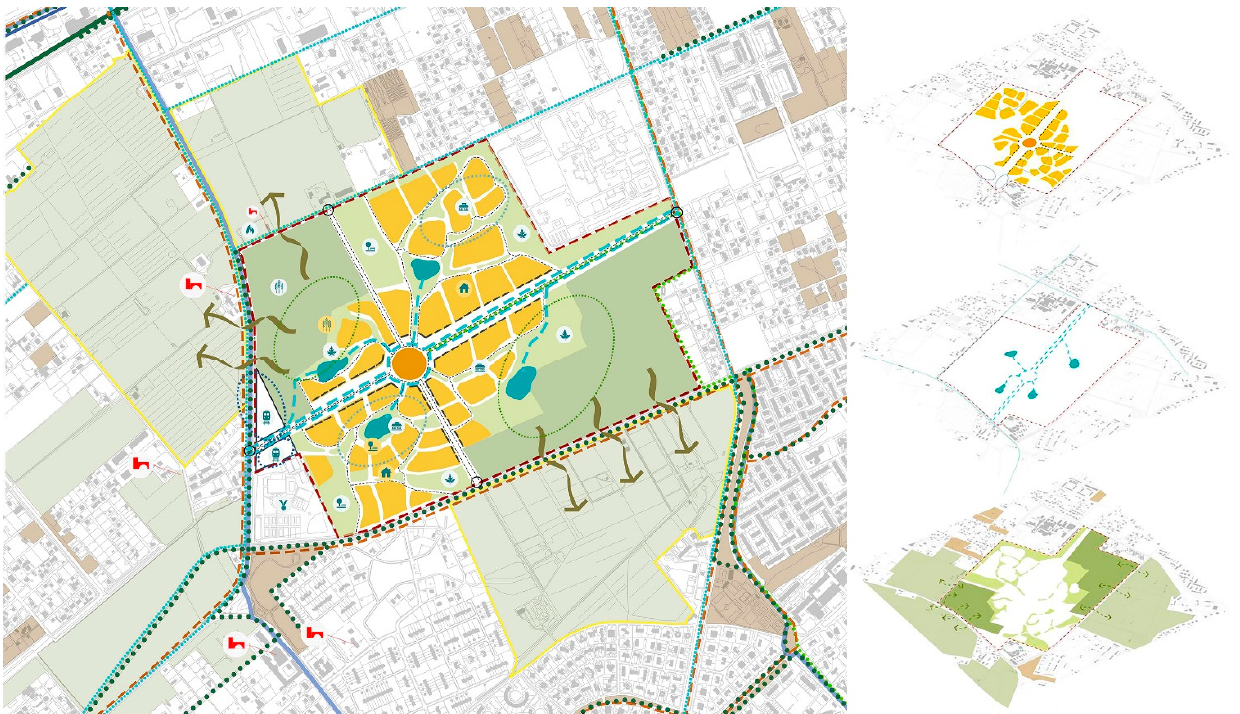
Figure 6. Rome Municipality X, Urban and Metropolitan Centrality Acilia–Madonnetta. Urban project. Preliminary organization scheme. (Source: elaborations by the students: S. Maiorano, F. J. Moran, A. Musto, C. Paloni, Urban Planning Laboratory of the Faculty of Architecture of Rome A.A. 2021–2022).